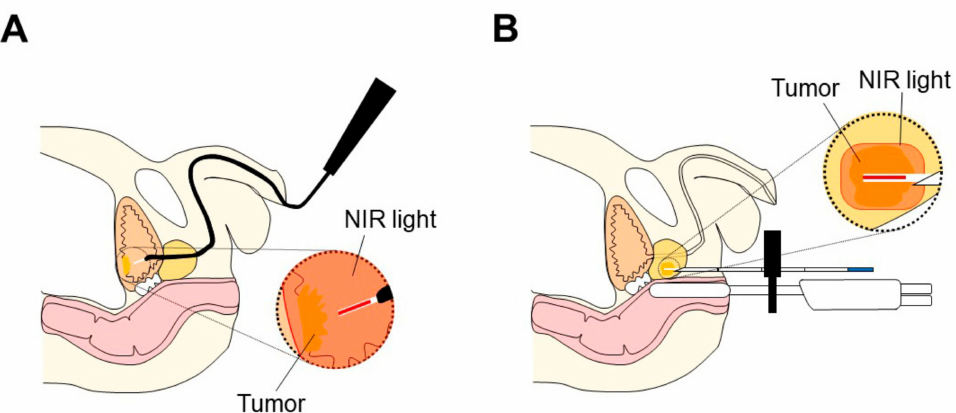
Figure 2. Scheme for NIR light irradiation to treat bladder and prostate cancer. NIR light is irradiated to a bladder tumor using a cylindrical diffuser via a cystoscope ( A ). NIR light is irradiated to a prostate tumor using a cylindrical diffuser via a needle ( B